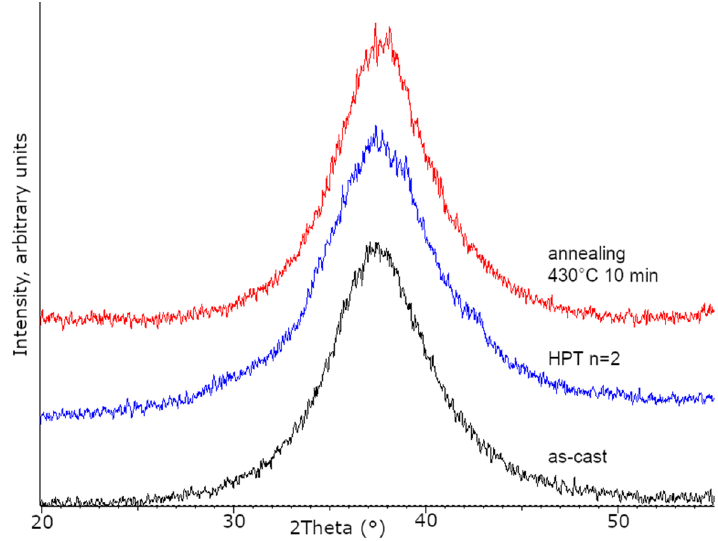
Figure 2. XRD results for the Vit105 BMG: as-cast; after HPT n = 2, BMG after relaxation annealing.